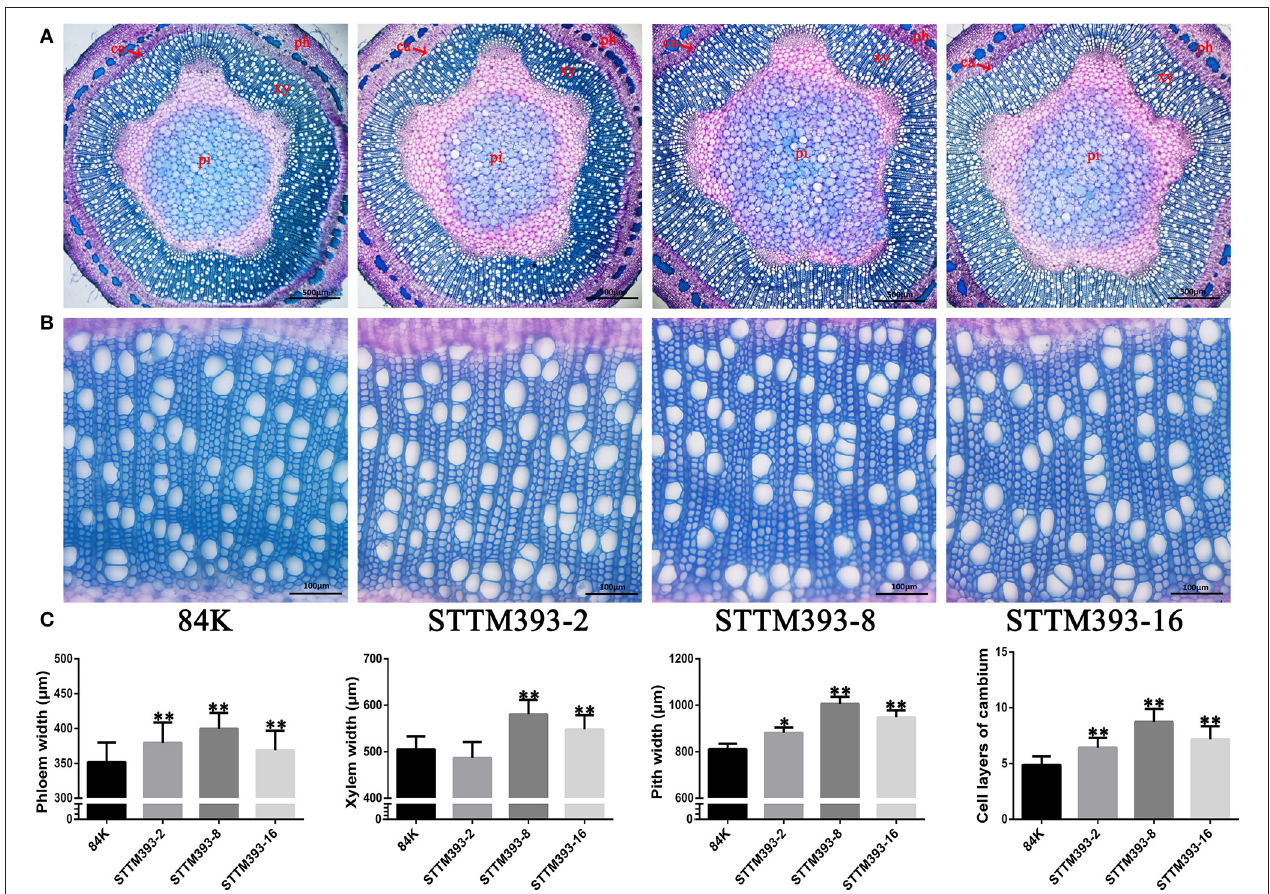
FIGURE 2 | The vascular tissues in STTM393 transgenic plants. (A) The cross-sections of the 15th internode of 3-month-old STTM393 and 84K control plants stained by toluidine blue (TBO), Bar = 500 µ m. ph, phloem; xy, xylem; pi, pith; ca, cambium. (B) The magnified xylem region of (A) , Bar = 100 µ m. (C) The statistical data for phloem, xylem, pith, and cambium layers of 3-month-old STTM393 lines and 84K control plants. The bars represent means ± SD ( n > 40). ** P ≤ 0.01, *0.01 < P ≤